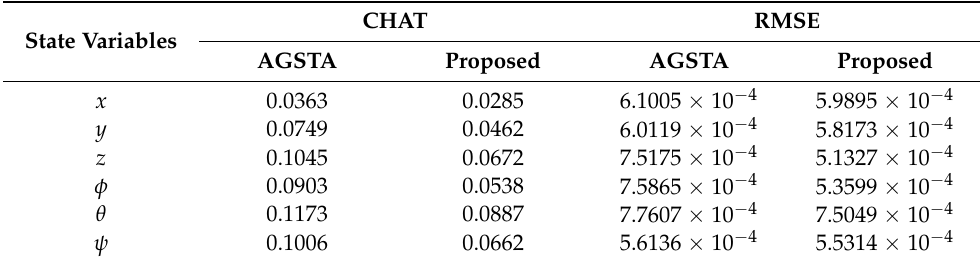
Table 3. Comparison of performance indices.